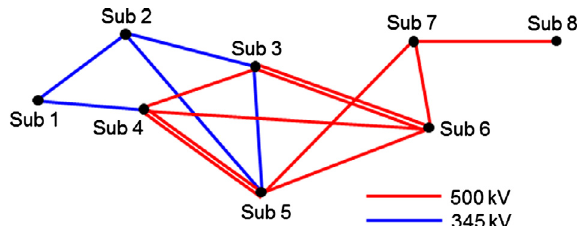
Fig. 7. Map of sample network. Note: Substation 1 and Substation 7 have no connection to ground (from Horton et